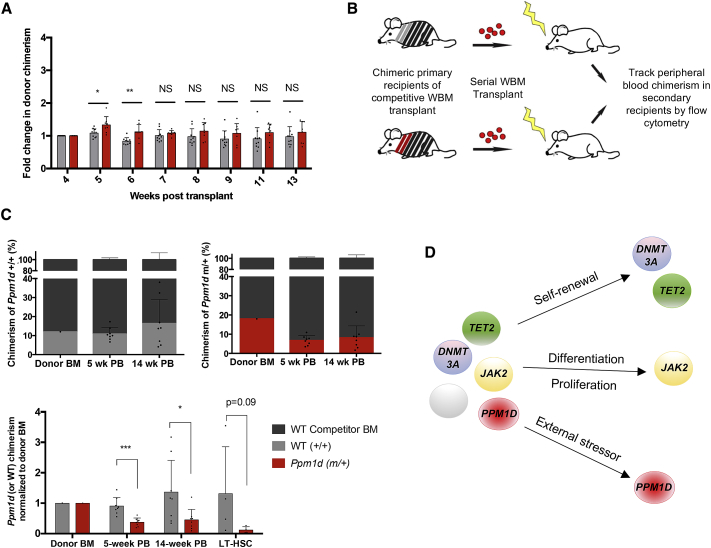
Ppm1d Mutant Cells Lose Their Survival Advantage in the Context of Bone Marrow Transplantation(A) Competitive whole bone marrow transplant was performed, with 20% of either R451X (Ppm1dm/+) or control (Ppm1d+/+) bone marrow cells mixed with 80% WT bone marrow cells. The recipient mice (n = 8 per group) were not treated with chemotherapy following transplant. Chimerism was monitored weekly by flow cytometry. Normalized values are shown using the initial chimerism at 4 weeks as the baseline for calculation of fold change (mean ± SD shown). ∗p < 0.05, ∗∗p < 0.01, ∗∗∗p < 0.001, and ∗∗∗∗p < 0.0001.(B) Schematic of the serial bone marrow transplantation performed 13 weeks after the initial competitive transplant shown in (A). 3 × 106 whole bone marrow (WBM) cells from the primary recipients of the transplant were serially transplanted into lethally irradiated secondary recipient mice (n = 8 per group). Peripheral blood chimerism was assessed in the secondary recipients 5 and 14 weeks following serial transplantation.(C) Graphs depicting the chimerism of the donor bone marrow (BM) at the time of serial transplantation, the chimerism in the peripheral blood (PB) of the secondary recipients at 5 and 14 weeks after transplantation (n = 8 per group), and the chimerism in LT-HSCs (n = 4 per group) at 18 weeks. The summary bar graph below shows chimerism at each time-point, normalized to the initial chimerism of transplanted bone marrow (red, Ppm1d mutant; gray, WT control). Mean ± SD is shown.(D) Model of clonal hematopoiesis, emphasizing that different genes have different fitness effects in different contexts. Intrinsic factors such as self-renewal have been shown to drive clonal expansion of DNMT3A and TET2 mutants, whereas aberrant differentiation and proliferation drive expansion of JAK2 mutations. With PPM1D, extrinsic stressors such as cisplatin promote expansion of the mutants.See also Figure S7.